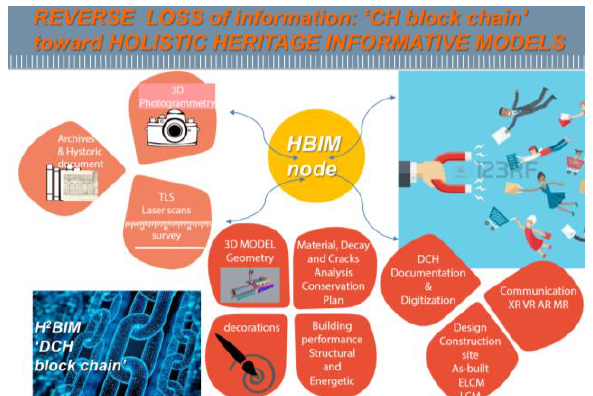
Figure 1. Holistic HBIM challenges: to reverse loss of information acquired during historical research, design and intervention 2. HOLISTIC HERITAGE INFORMATION MODELLING (HHBIM) 2.1 BIM adoption: the EUPPD24/2014 directive. Gaps and barriers, time-cost effectiveness.